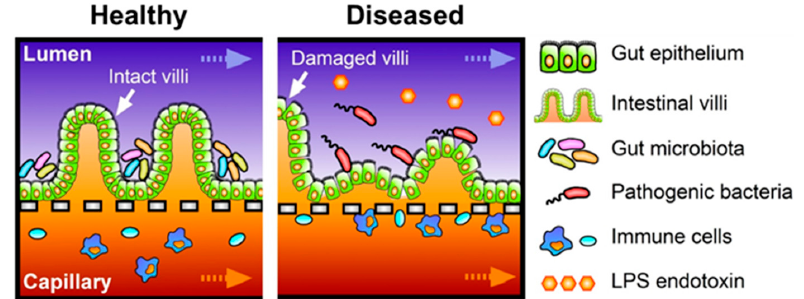
Figure 4. A simplified schematic illustration comparing the human intestinal microenvironment in healthy versus diseased conditions caused by chronic inflammation. In the diseased condition, inflamed intestinal microenvironment results in the leaky gut epithelium in accordance with the infection of pathogenic bacteria, increased level of bacterial endotoxins such as lipopolysaccharides (LPS), and recruitment of circulating immune cells.